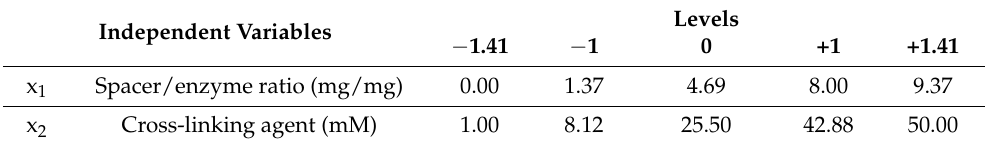
Table 3. Independent variables and their respective levels and real values used in the proposed CCRD